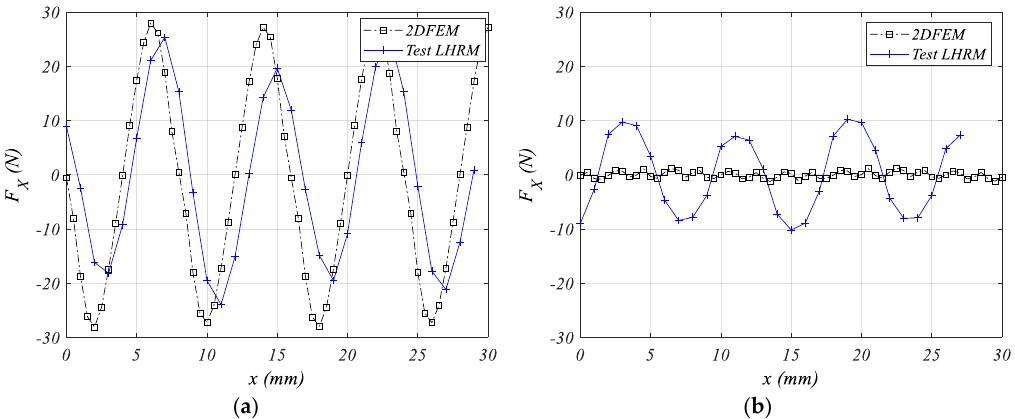
Figure 15. 2DFEM vs. experimental detent force comparison results. ( a ) s = 0 mm. ( b ) s = 4 mm.